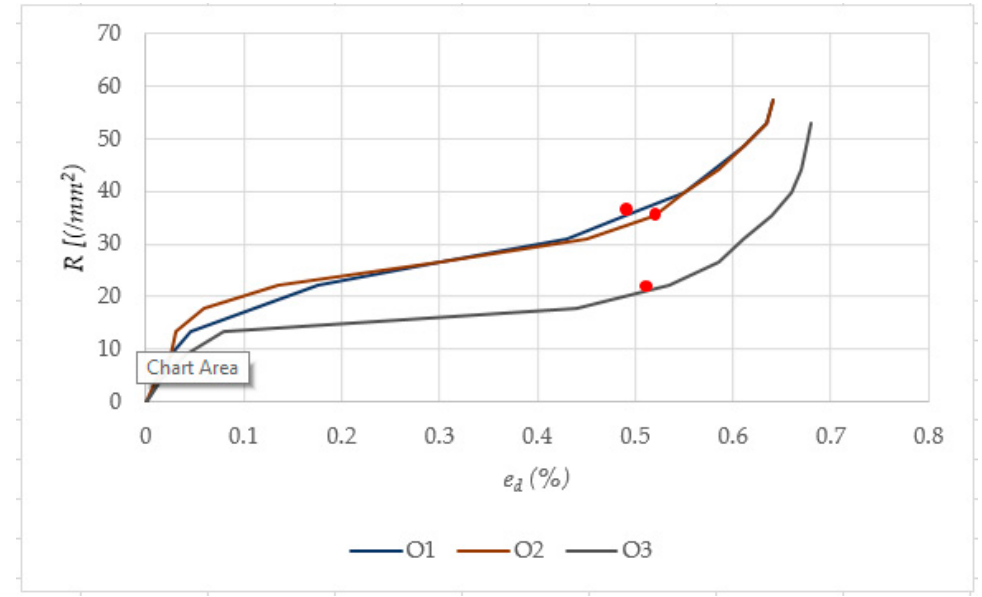
Figure 8. Stress–strain curves for samples reinforced with cylindrical wire mesh.